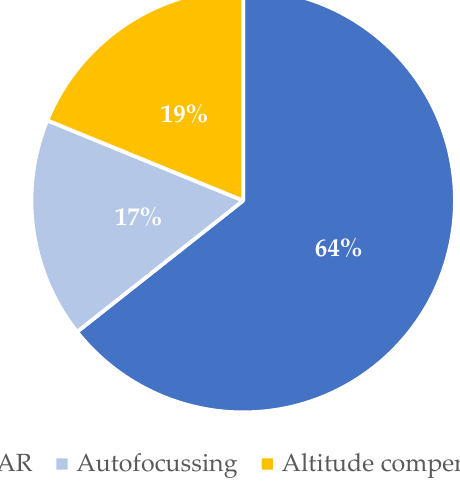
Figure 10. Percentage of the paper in terms of imaging method.